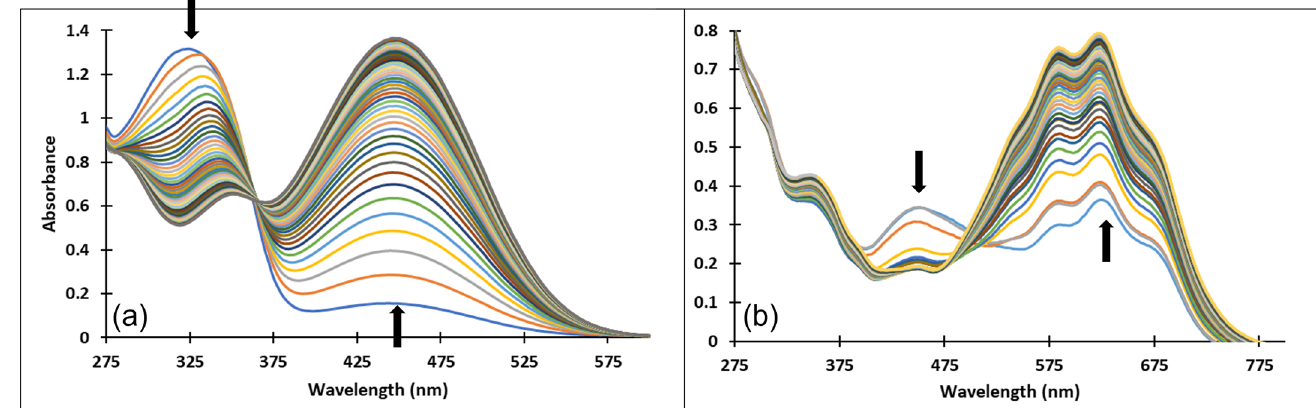
Figure 8. Spectral variations of a solution of compound 3 after: ( a ) direct pH-jump from pH 2.07 to pH 12.13 and ( b ) reverse pH-jump from pH 12.06 to pH 7.23.